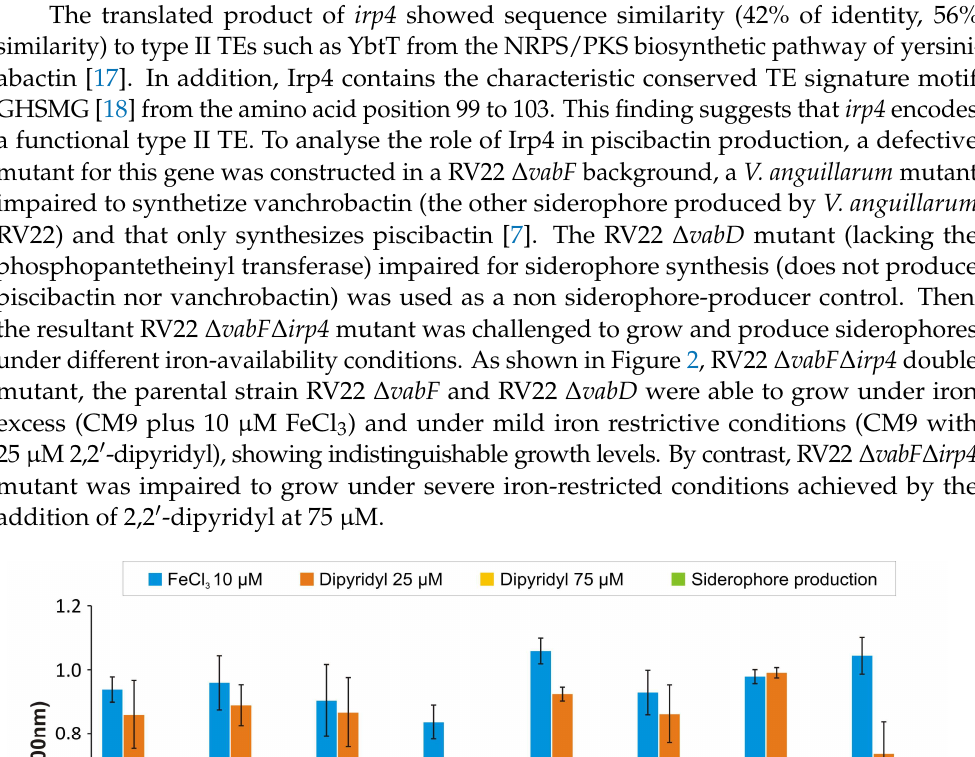
Figure 3. The cross-feeding assay to evaluate the ability of the tested strains (RV22 Δ vabF Δ irp4 , RV22 Δ vabF Δ irp8 , RV22 Δ vabF , and RV22 Δ vabD ) to produce siderophores that the indicator strain (RV22 Δ vabF , which express the piscibactin transporter FrpA) could use as iron source to grow under iron limited conditions. 2.2. Irp8 Is Required for Piscibactin Secretion The irp -HPI encodes a putative MFS-like exporter named Irp8 whose predicted pro- tein structure shares the 12 transmembrane segments typically found in this type of efflux pumps [19]. To analyse the putative role of Irp8 in piscibactin exporting route, an in-frame deletion mutant of the irp8 gene was constructed and its growth ability and siderophore production were evaluated (Figure 2). When grown in iron excess or mild iron-restrictive conditions, the mutant RV22 Δ vabF Δ irp8 showed a growth ability indistinguishable from that of the parental strain RV22 Δ vabF . By contrast, it was unable to grow under iron lim- itation at 75 µM of 2,2′-dipyridyl. The decrease in the growth levels of RV22 Δ vabF Δ irp8 under iron restriction correlates with a lower siderophore production (Figure 2). None- theless, the Δ irp8 mutant achieved an A 630 ca. −0.15 in the CAS liquid assay, which sug- gests that irp8 deletion did not totally abolish siderophore production. Several studies suggest that most siderophore exporters mutants show intermediate growth and